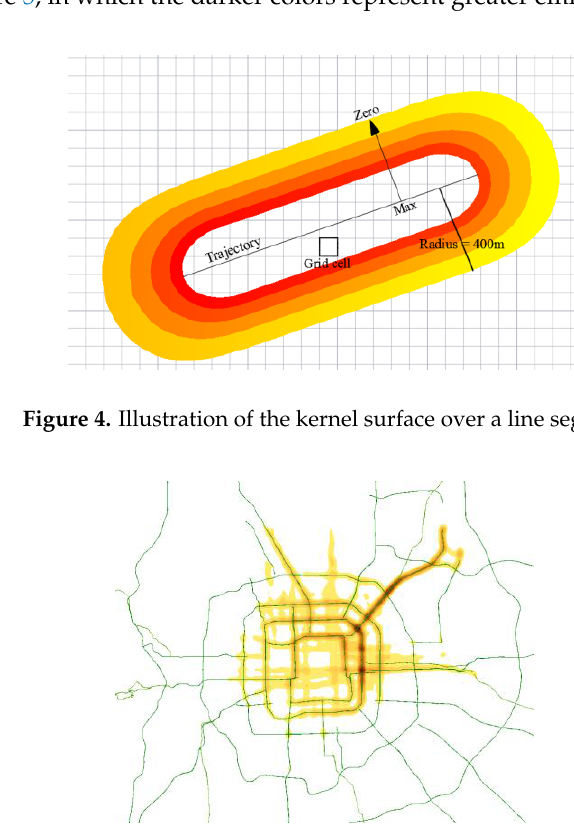
Figure 5. Diagram of the kernel analysis result.